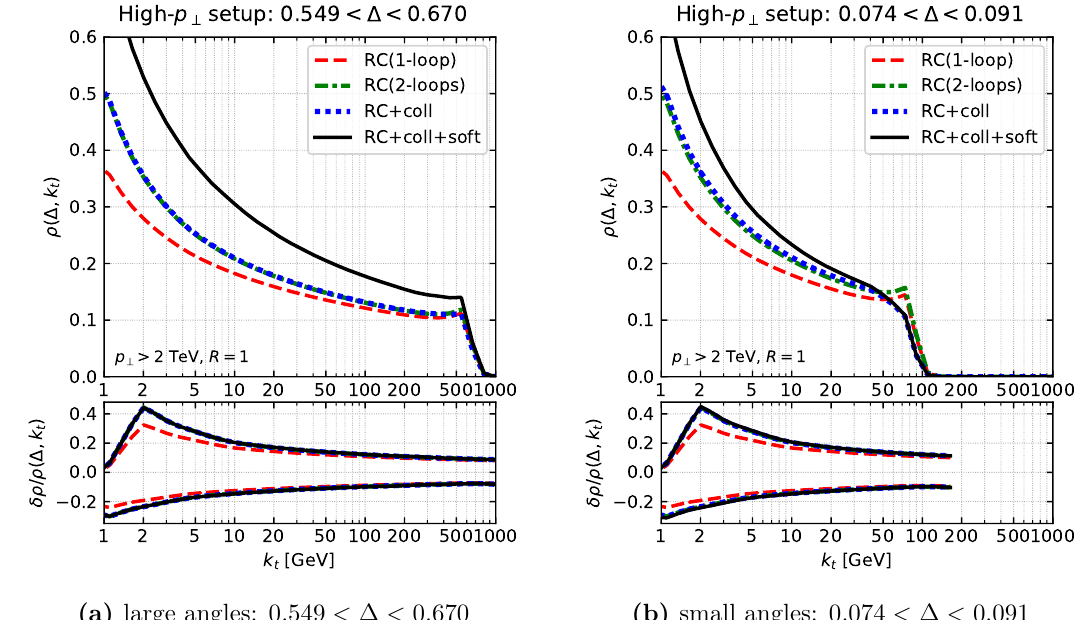
Figure 6. Slices of the resummed primary Lund-plane density (cid:26) resum ((cid:1) ; k t ) at constant (cid:1). The upper panels correspond to the density (cid:26) resum ((cid:1) ; k t ) itself while the lower panels show the relative scale uncertainties (cid:14)(cid:26) ((cid:1) ; k t ). We show results including di(cid:11)erent contributions: the dashed(red) (cid:26) line includes only 1-loop running, the (dash-dotted) green line includes 2-loop running-coupling corrections, the (dotted) blue lines adds the resummation of collinear e(cid:11)ects ((cid:13)avour changes and leading-parton momentum), and the solid black line is our full resummed result, including soft-gluon resummations as